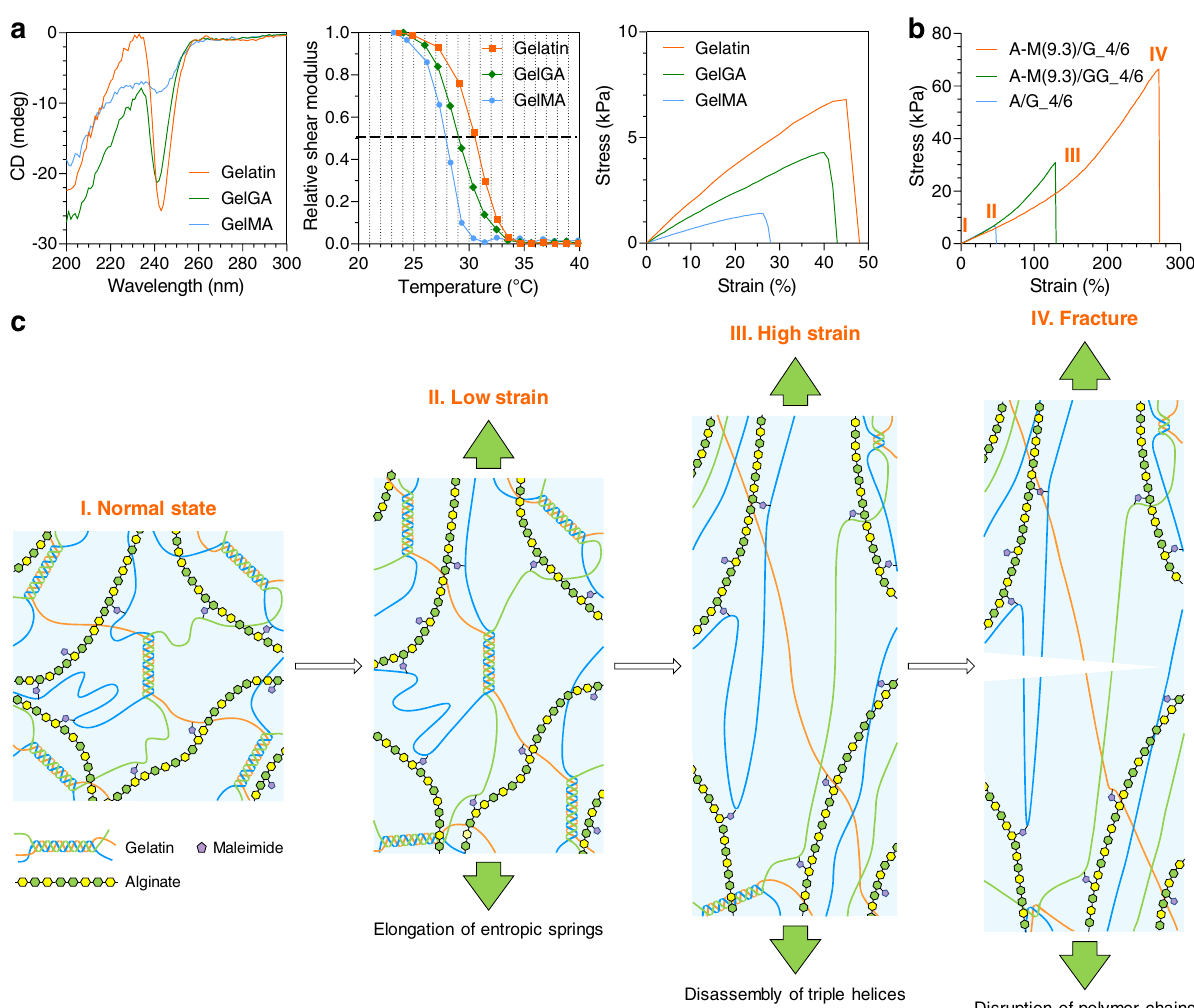
Fig. 2 Mechanism on the toughness of A – M(9.3)/G_4/6 hydrogel. a Effects of different chemical modi fi cations to gelatin on the molecular structure, melting point, and tensile behavior of its hydrogel. b Comparison in tensile behavior among A – M(9.3)/G_4/6, A – M(9.3)/GG_4/6, and A/G_4/6 hydrogels. c Schematic illustration for the mechanism on the toughness of A – M(9.3)/G_4/6